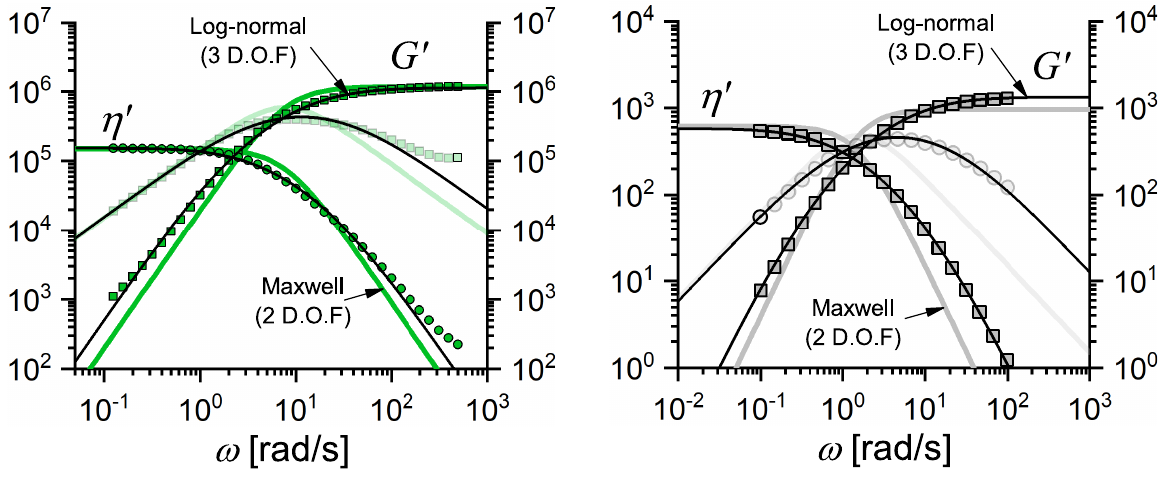
Figure 13: Three parameters are satisfactory to describe the linear viscoelastic behavior of therapy putties and PVA-Borax samples. The log-normal (3 D.O.F.) adds only one parameter related to polydispersity but when fit to the data by a reduction of the residuals, is a marked improvement over the single-mode Maxwell model (with 2 D.O.F.). (left) ‘firm’ putty and (right) 2.75 wt % PVA - 1.5wt % Borax sample.